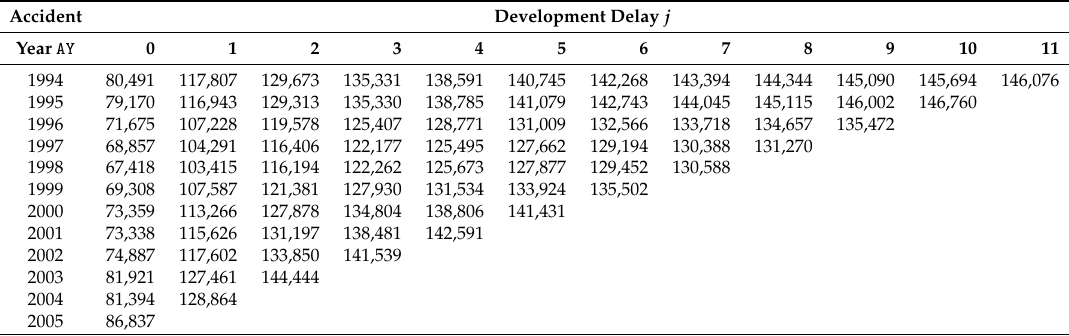
Table 5. Triangle of cumulative claims payments (in 10,000 CHF) of the simulated data. Accident